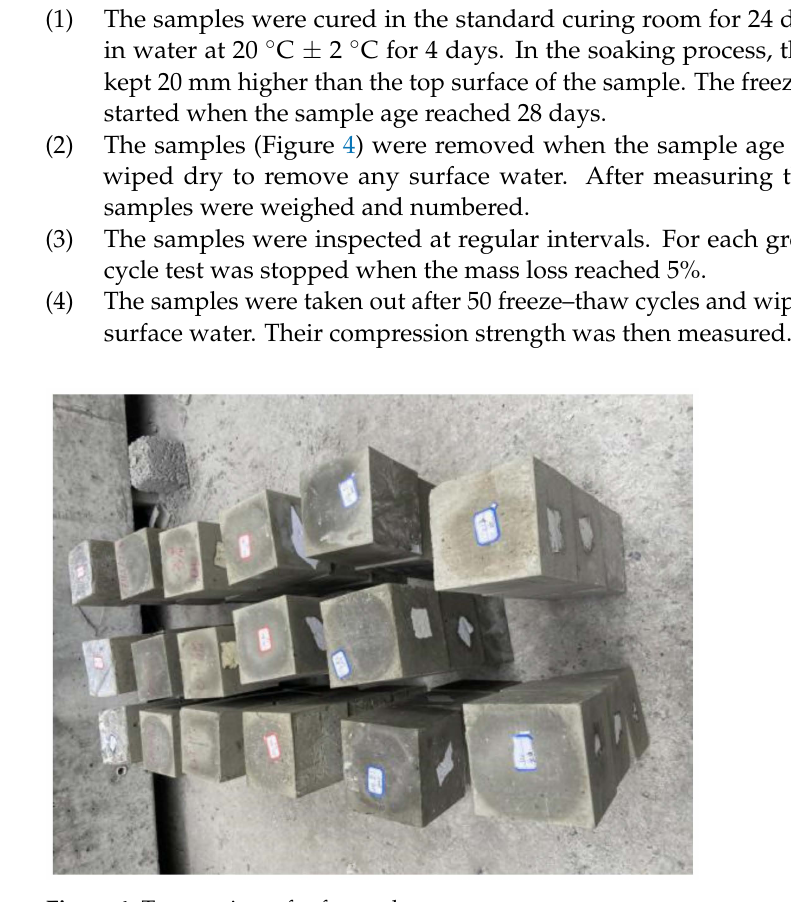
Figure 4. Test specimen for freeze